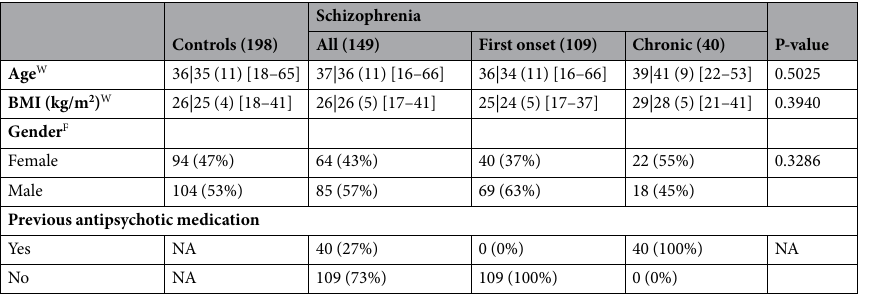
Table 1. Demographic characteristics. Numerical values are shown as Mean|Median (Standard Deviation) [Min-Max]. Key: F , Fisher’s exact test; W , Wilcoxon test; P-values are calculated using the control group as the reference (i.e. difference between the patient and control